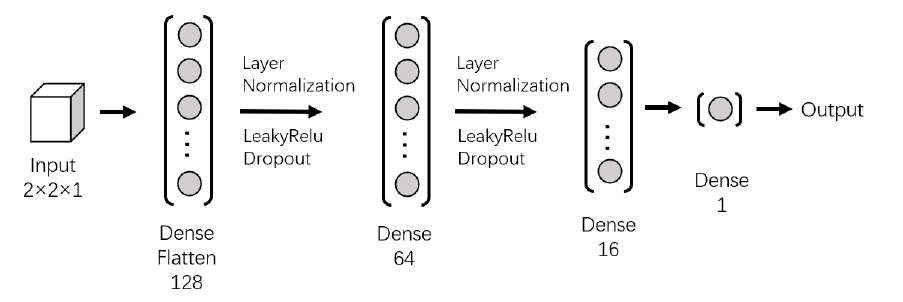
Figure 15. The structure of the discriminator for the eye dataset.